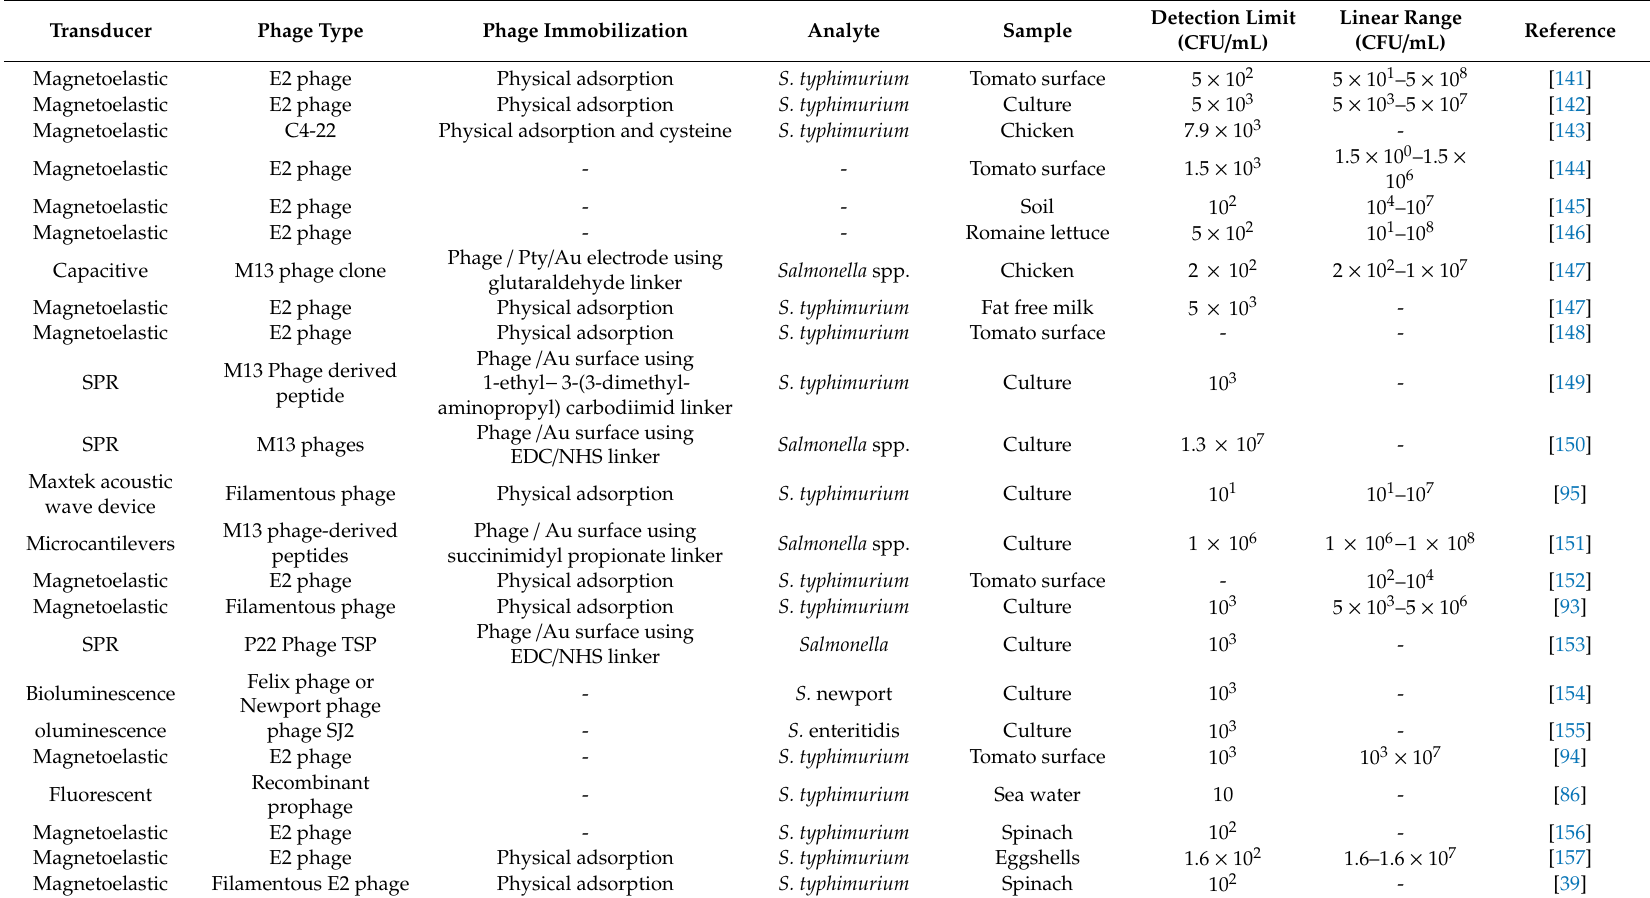
Table A1. Bacteriophage based sensors for detection of